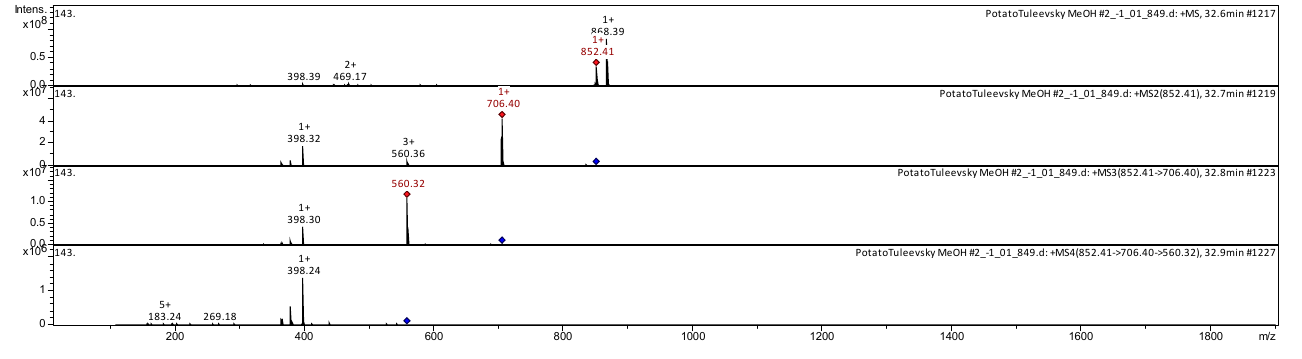
Figure 5. CID-spectrum of α -chaconine from extracts of S. tuberosum (variety Tuleevsky), m / z 852.41.